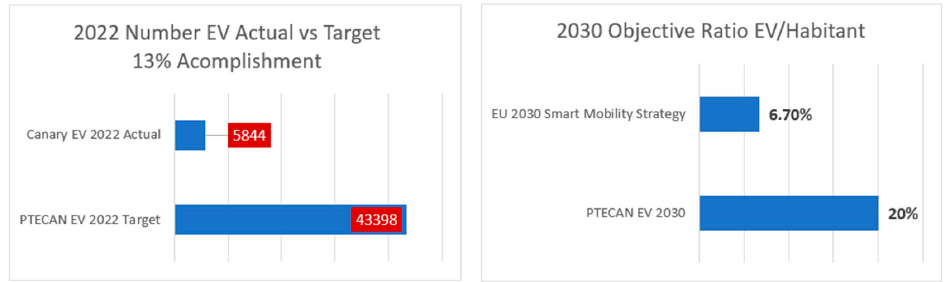
Figure 10. EV 2022 actual vs. objective (PTECAN) and 2030 objective (ratio EV/habitant) PTECAN vs. EU Smart Mobility Strategy. vs. EU Smart Mobility